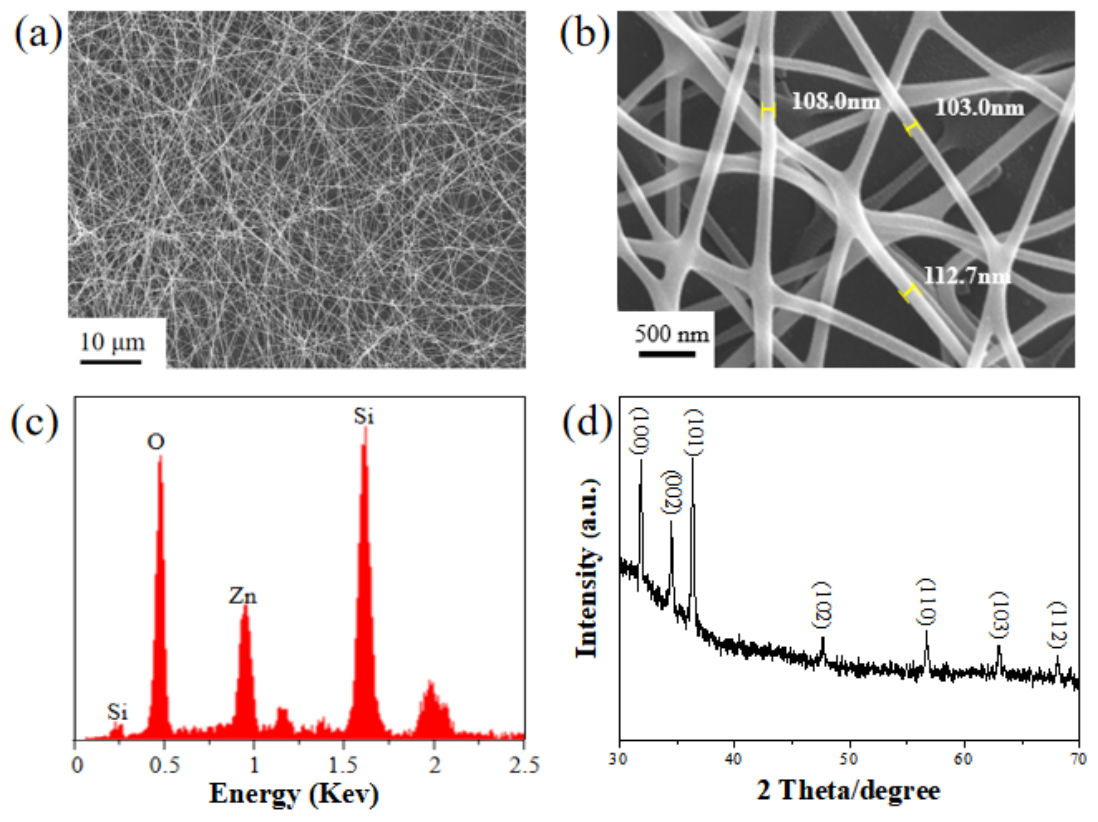
Figure 2. Morphology and microstructure studies of the ZnO NWs. ( a , b ) SEM images of ZnO NWs at different magnifications. ( c ) EDS spectrum of ZnO NWs. ( d ) XRD spectrum of annealed ZnO NWs.